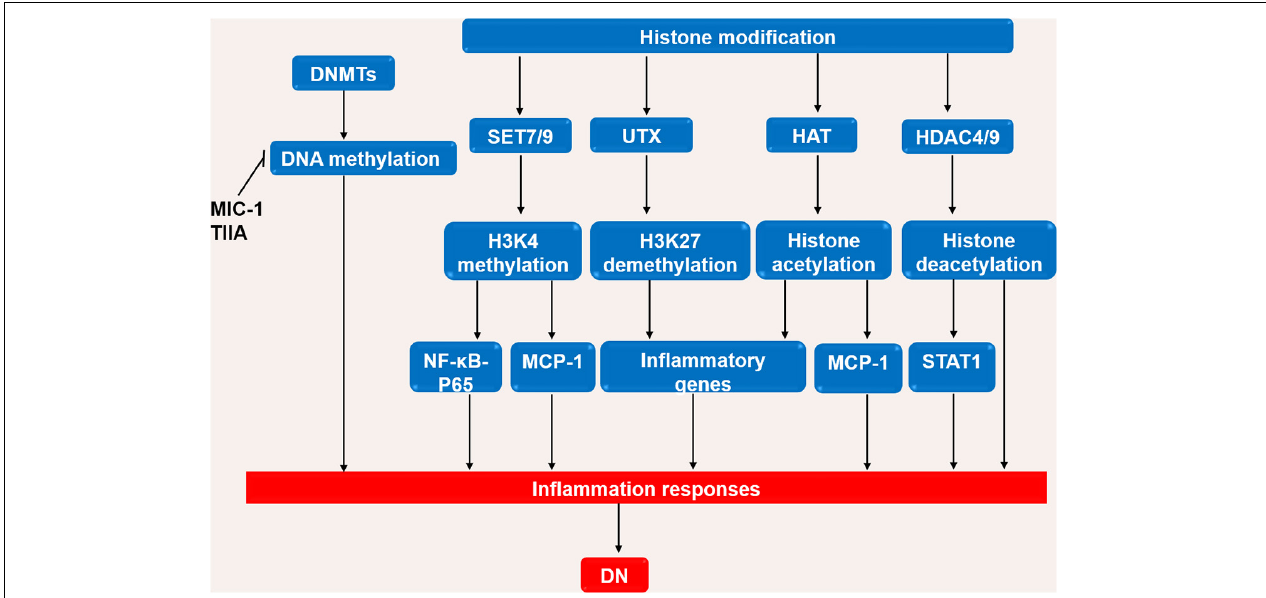
FIGURE 1 | Interaction of immune cells, kidney intrinsic cells and epigenetic modifications. DNA methylation, histone modifications, and non-coding RNA modifications activate inflammatory pathways by interactions of immune cells and kidney intrinsic cells. OS, oxidative stress; ROS, reactive oxygen species; HG, high glucose; Ang II, angiotensin II; AGE-RAGE, advanced glycation end-products-receptor for advanced glycation end products; IL, interleukin; TNF, tumor necrosis factor; MCP-1, monocyte chemoattractant protein 1; NF- κ B, nuclear factor- κ B; JAK-STAT, Janus kinase/signal transducer and activator of transcription; NRF2, Nuclear Factor-2 Erythroid Related Factor; NLRP, NOD-like receptor pyrin domain-containing